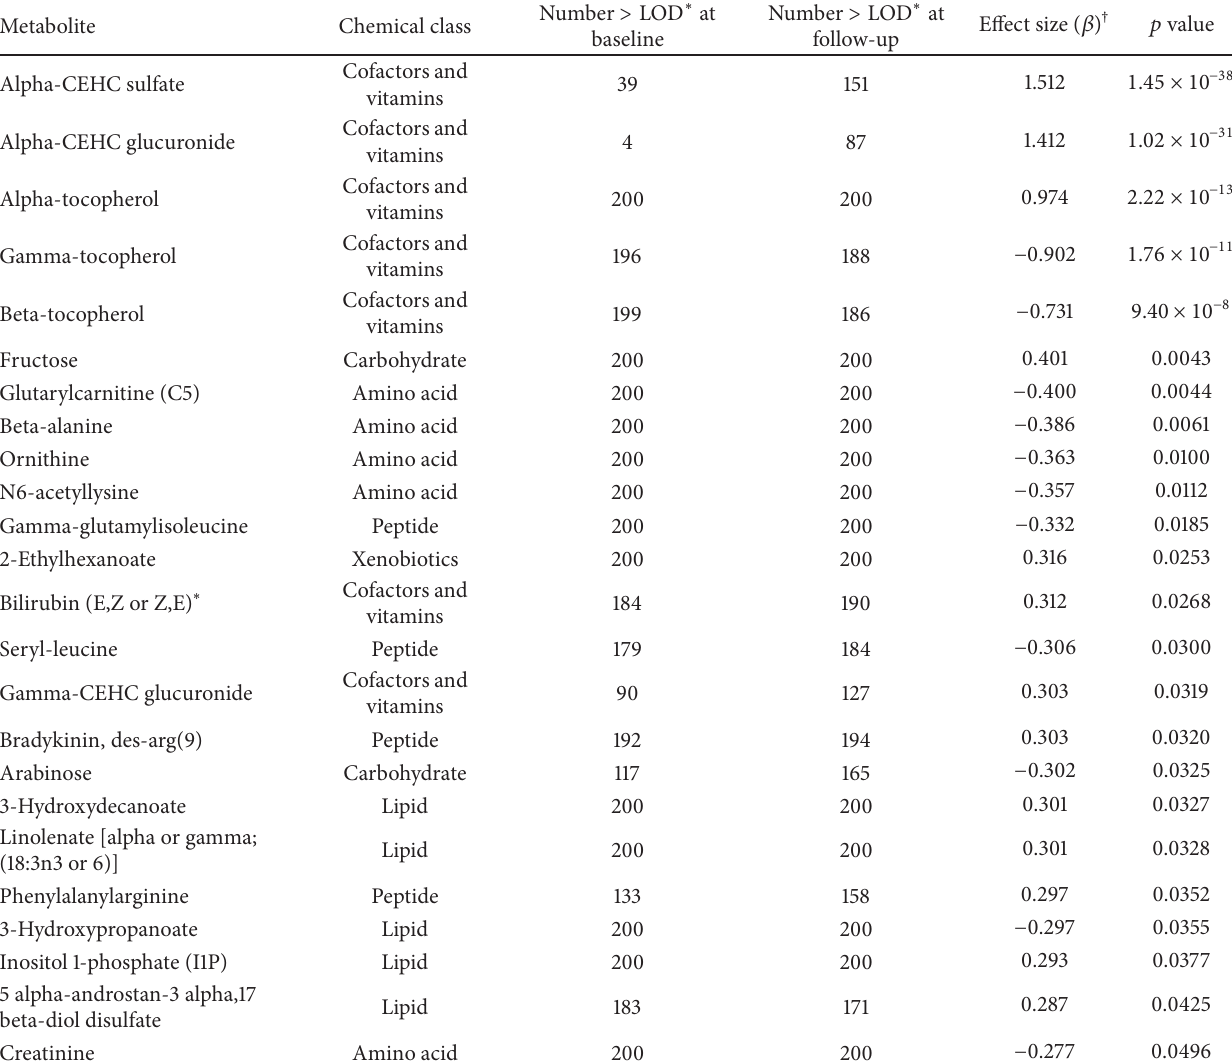
Table 2: Metabolites that changed significantly ( 𝑝 < 0.05 ) in response to ATA supplementation in the ATBC Study, ranked by statistical significance (smallest to largest 𝑝